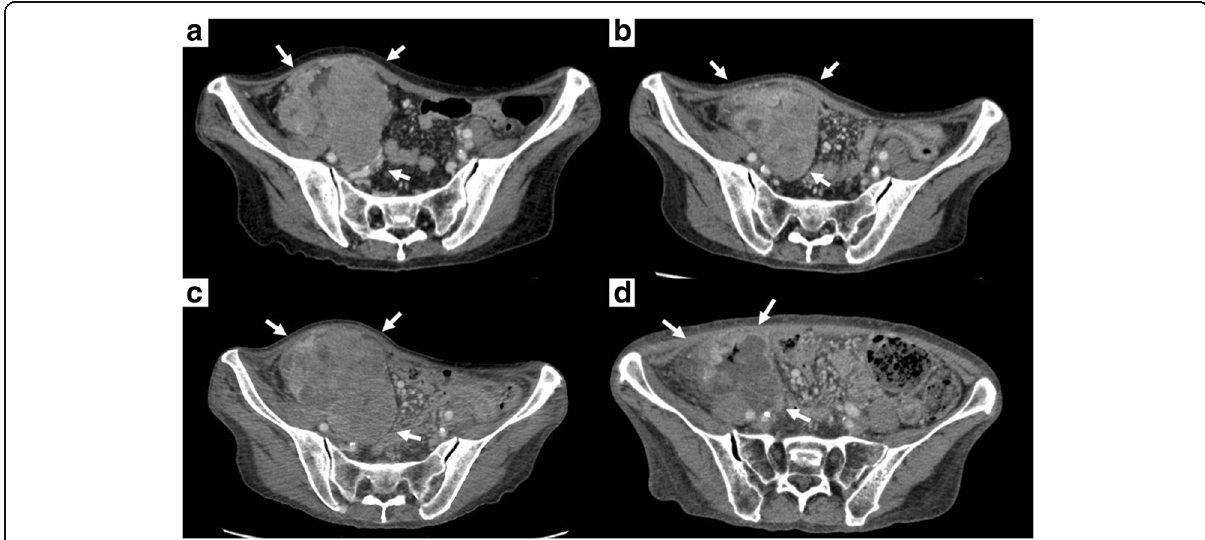
Fig. 2 Computed tomography images. a Before treatment, 8.6-cm-diameter tumor infiltrating the abdominal wall, small intestine, and retroperitoneum. b After four cycles of chemotherapy, the tumor slightly shrank to 6.9 cm in diameter. c After eight cycles of chemotherapy, the tumor enlarged to 10 cm in diameter. d After radiotherapy, the tumor reduced to 6.6 cm in diameter with intratumor liquefaction